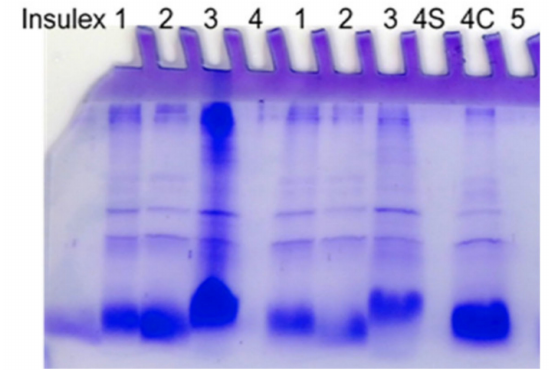
Figure 5. Polyacrylamide gel electrophoresis of a Mexican Hirsutella citriformis strain sample. Lane 1 = mycelium; lane 2 = supernatant; lane 3 = mycelium; lane 4S = gummous material dissolved in solvent and sonicated (five pulses/40 W/30 sec). This material was slightly frag- mented; lane 4C = the gummous material was cut, and a fragment was directly deposited as sample; lane 5 = solvent. Note that samples dissolved in a solvent were off the gel